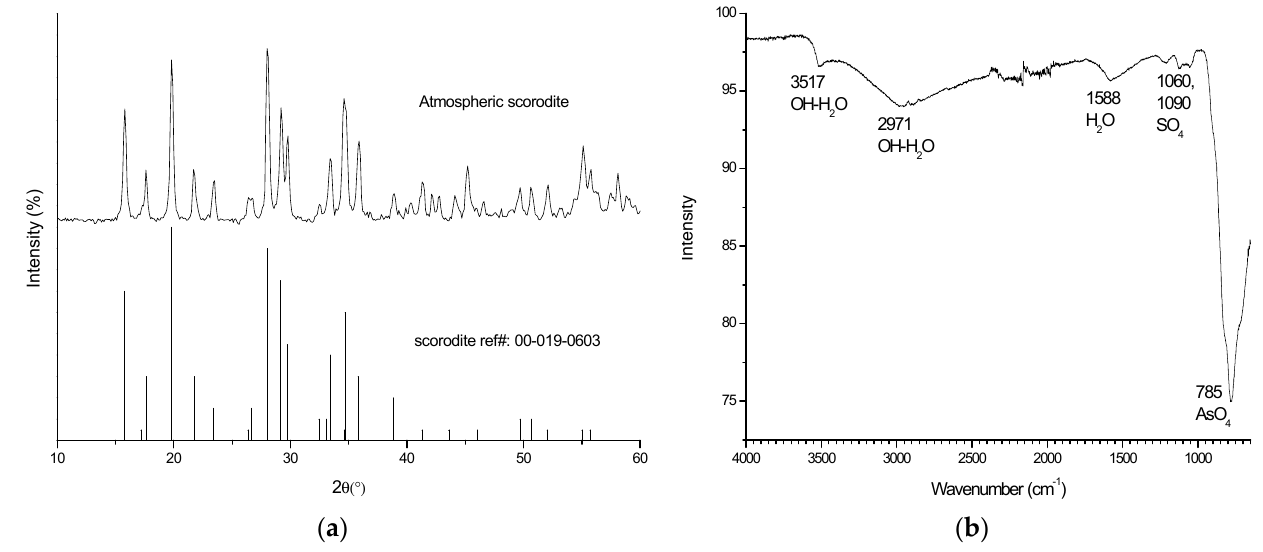
Figure 2. XRD ( a ) and FTIR ( b ) spectra of the atmospherically precipitated scorodite.